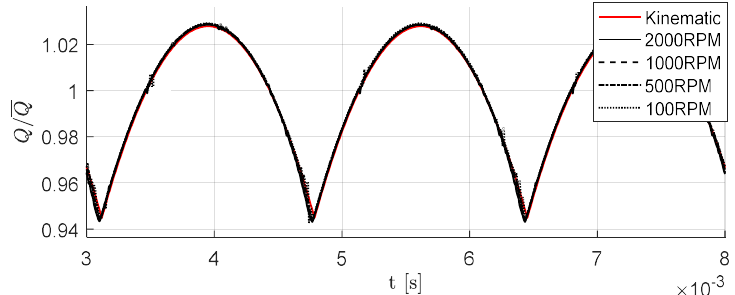
Figure 18: Reference Pump with maximum-delivery groove positioning simulated fluid-dynamic flow ripple at 0 bar pressure differential and different shaft speeds, as well as the kinematic flow ripple plotted.